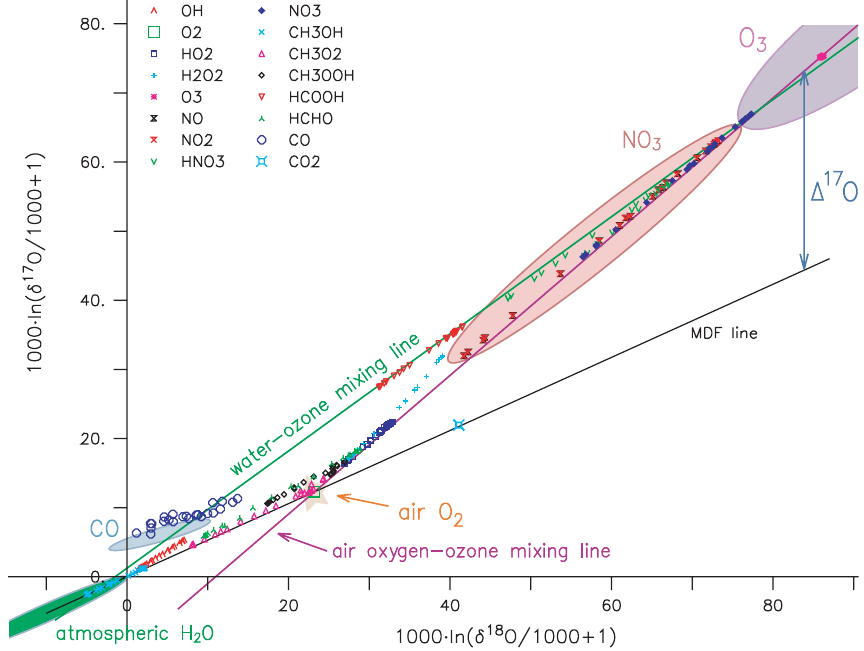
Fig. 6. Triple-isotope plot of the main oxygen-bearing gas-phase species composition simulated in the reference setup. The shaded areas indicate typical compositions observed for certain species reported by Brenninkmeijer et al. (2003) and Thiemens (2006).